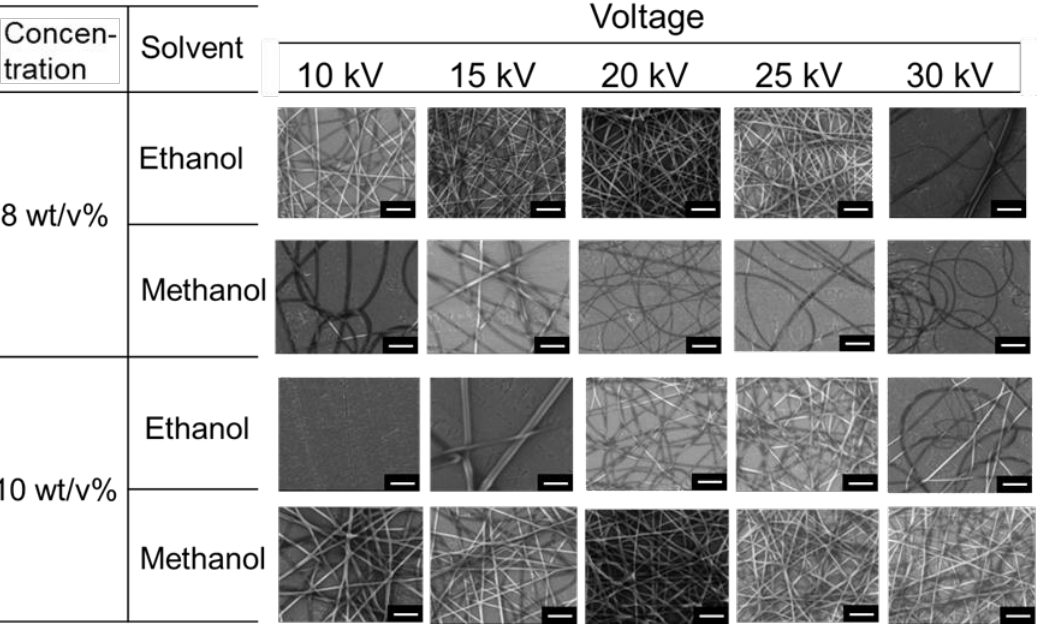
Figure 2. Effects of applied voltage and polymer concentration on the poly(acrylic acid) (PAA) fiber formation and morphologies (scale bar: 10 μm).